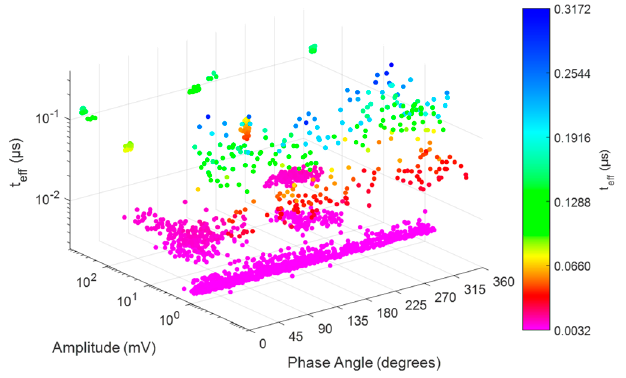
Figure 5. Example of PRPD- t eff pattern representation, isometric representation of phase angle-amplitude- t eff .